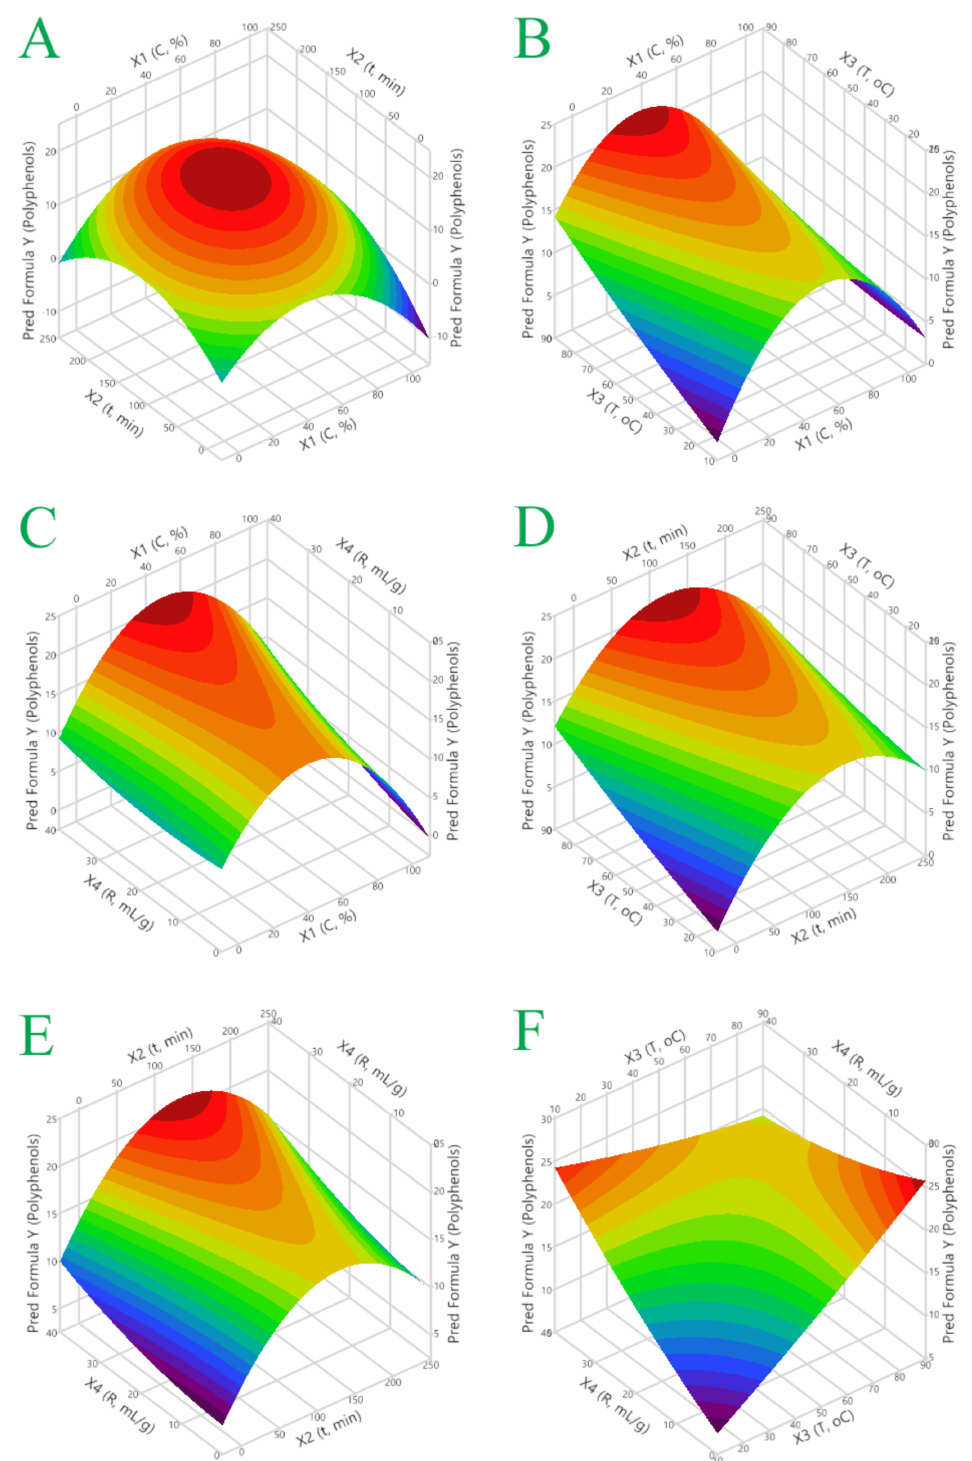
Figure 2. 3D graphs depicting the effect of the process variables considered on the response (polyphe- nols, mg GAE/g), for the optimization of spent coffee grounds extraction performed with hy- droethanolic solutions. Plot ( A ), covariation of X 1 ( C , %) and X 2 ( t , min); plot ( B ), covariation of X 1 ( C , %) and X 3 ( T , ◦ C); plot ( C ), covariation of X 1 ( C , %) and X 4 ( R , mL/g); plot ( D ), covariation of X 2 ( t , min) and X 3 ( T , ◦ C); plot ( E ), covariation of X 2 ( t , min) and X 4 ( R , mL/g); plot ( F ), covariation of X 3 ( T , ◦ C) and X 4 ( R ,